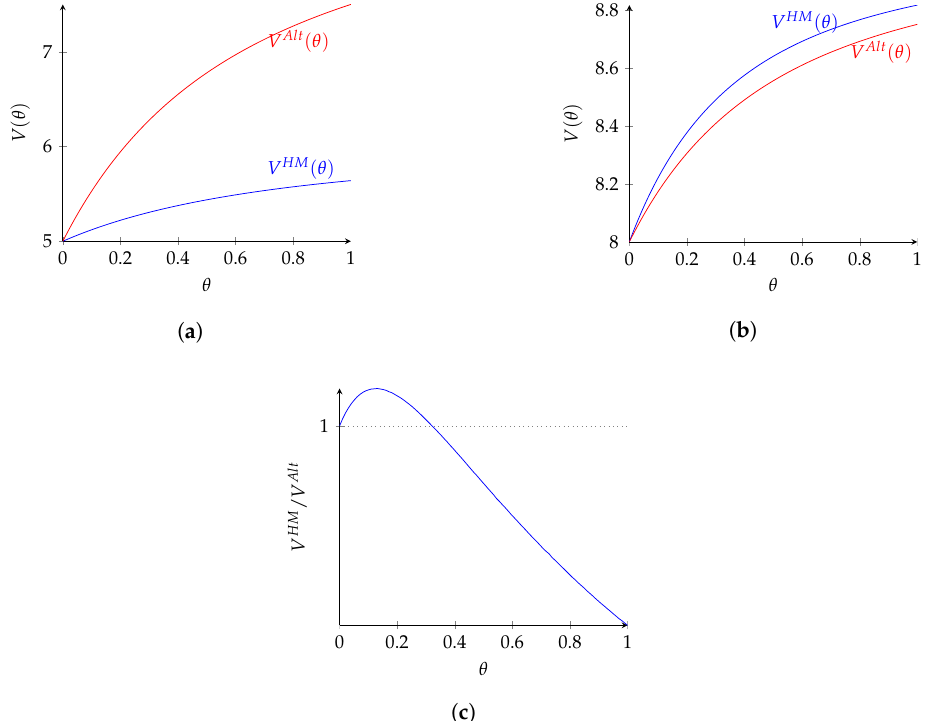
p 1 p 1 p 0 Figure 2b: Comparing principal’s profits for p 2 − ≥ −